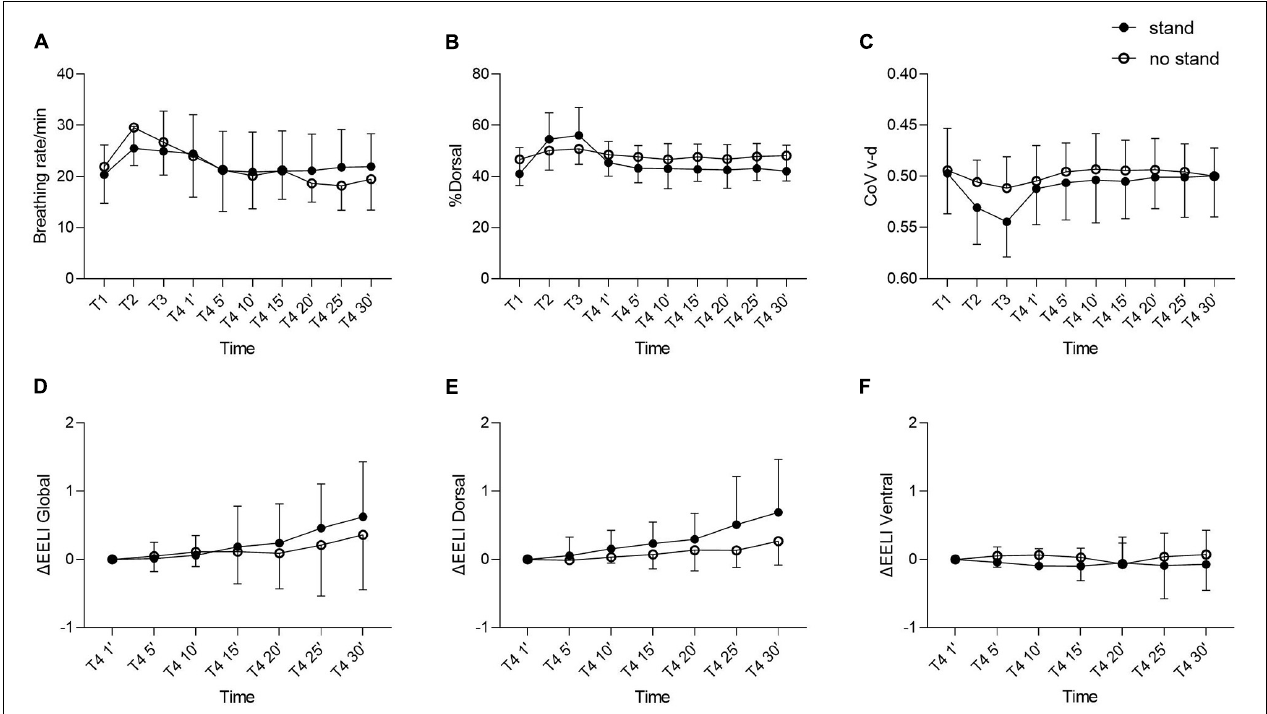
FIGURE 3 | (A) Breathing Rate. (B) %Dorsal. (C) CoV v-d. (D) (cid:49) EELI global. (E) (cid:49) EELI dorsal. (F) (cid:49) EELI ventral. Comparison of the results of the standing and no standing subgroups during the 30-min follow-up after the mobilization. All panels show mean values with SD. %Dorsal, percentage of dorsal ventilation; CoV v-d, center of ventilation ventral-dorsal; (cid:49) EELI, change in end-expiratory lung